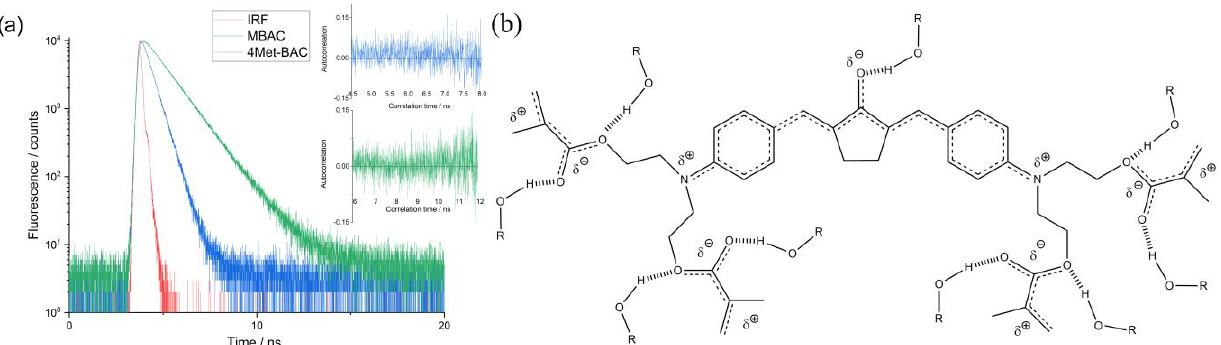
Figure 3. ( a ) Fluorescence kinetics decay of MBAC (blue) and 4Met-BAC (green) in propanol; excitation 475 nm. ( b ) Proposed hydrogen bonding of 4Met-BAC molecules in alcohol solvent.